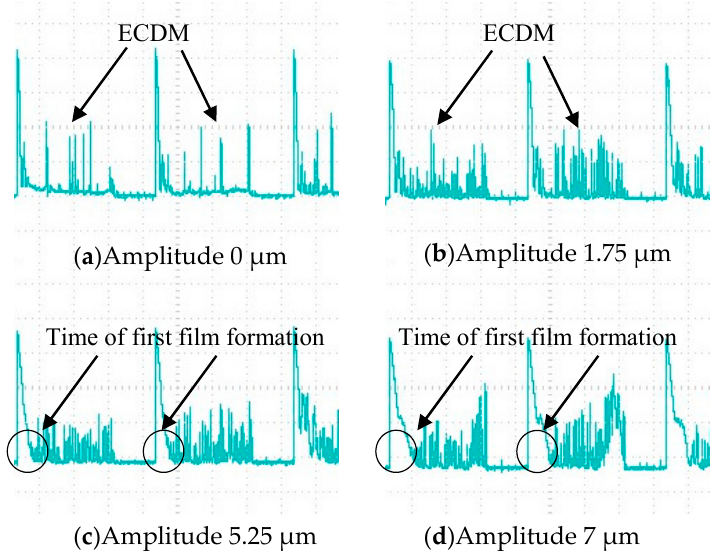
Figure 9. Current waveform under different amplitude.